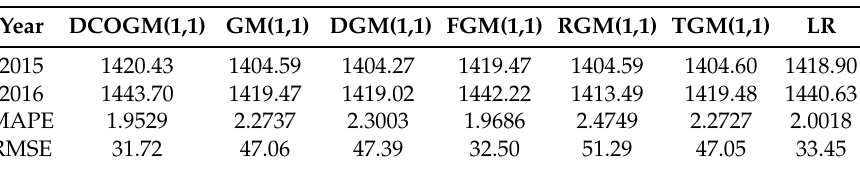
Table 5. Forecasting results of the electricity consumption for Shanghai City in China by the compared models [Unit: 100 million kwh].